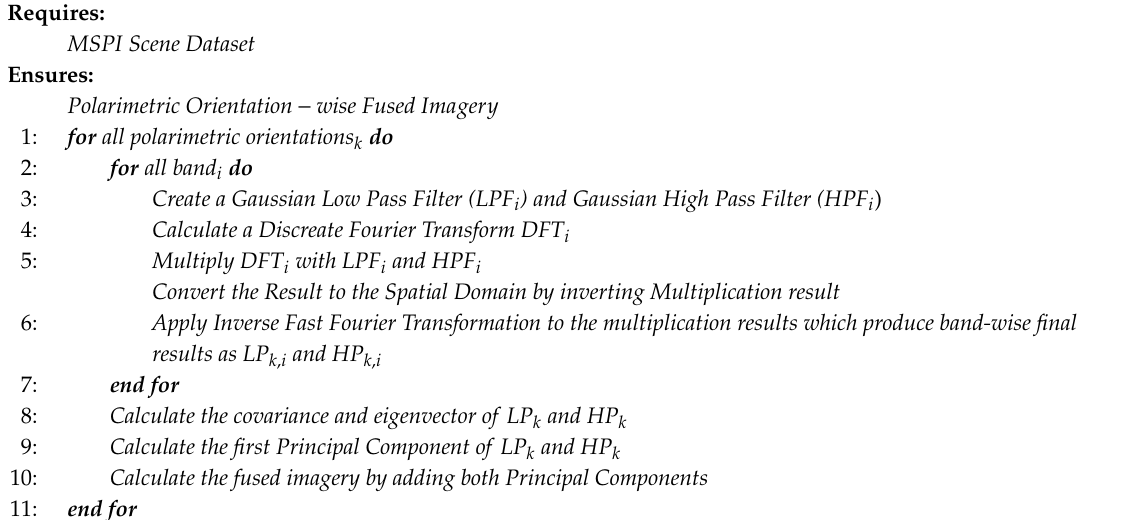
Algorithm 2. Polarimetric Orientation-wise Multiband Fusion